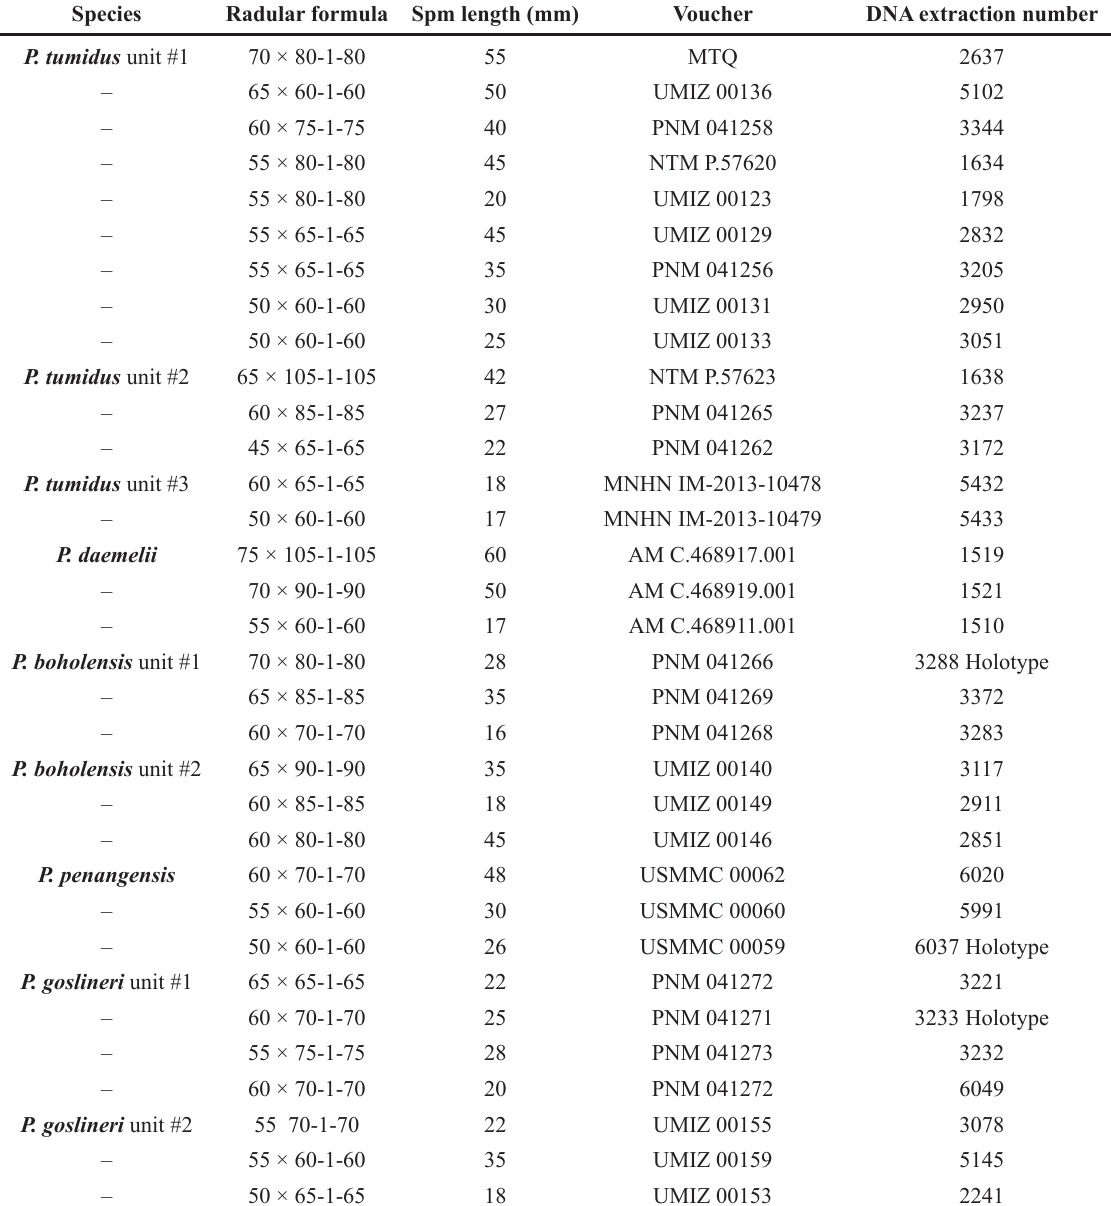
Table 4. Radular formulae for the five species of Paromoionchis gen. nov. following the same format: number of rows × (number of lateral teeth per left half row - 1 rachidian tooth - number of lateral teeth per right half row). Each DNA extraction number corresponds to one particular individual. DNA extraction numbers are used on Figs 1–4 (the phylogenetic trees), Table 1 and in the material examined section for each